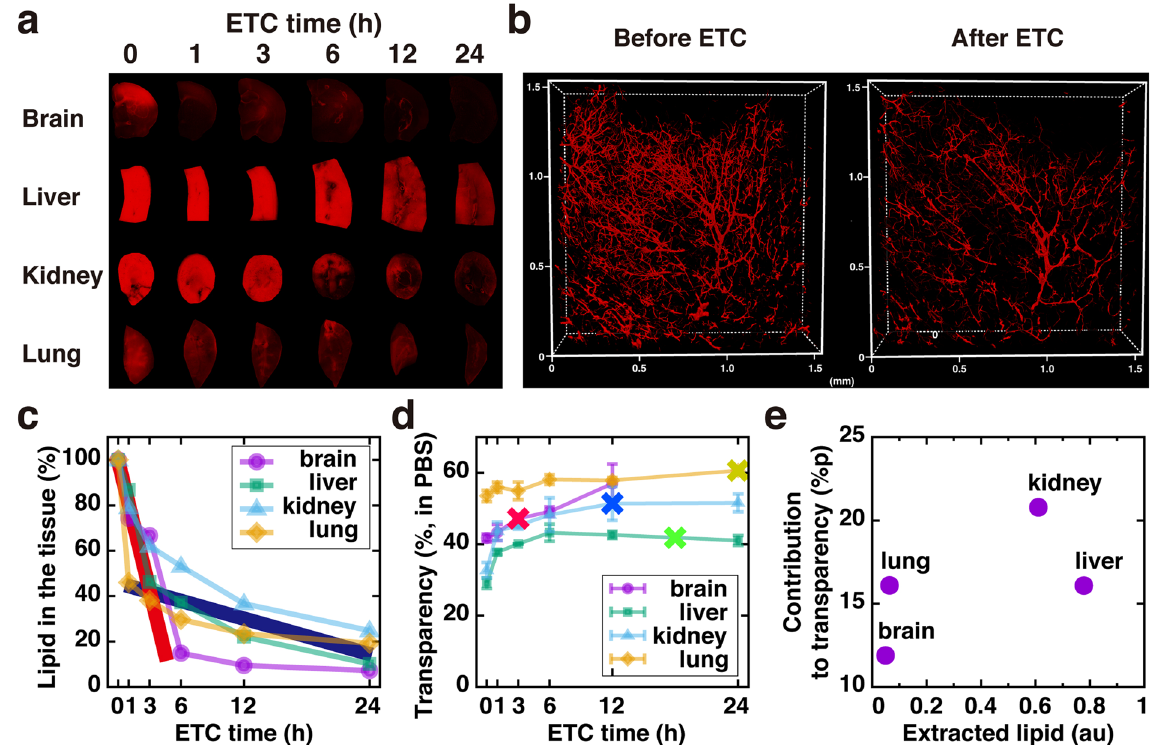
Figure 2. Evaluation of lipid extraction (a) Images of DiI-stained tissue at different ETC time points. (b) Pre-labeled CM-DiI signals remaining in the brain vasculature before (left) and after 2 hr ETC (right). Lipid extraction rate (c) and transparency (d) at different ETC time points. “X” marked points in (d) indicate an optimal time point for each organ for maximal clearing. N = 3, 3, 6, 6 for brain, lung, liver and kidney, respectively. (e) Correlation graph of extracted lipid and contribution of lipid extraction to the improvement of the transparency of each